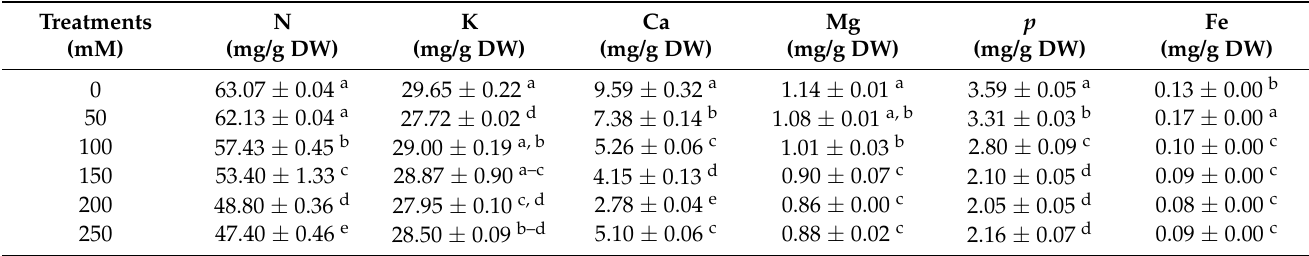
Table 1. Compositions of nitrogen, potassium, calcium, magnesium, phosphorous, and iron in the leaves of H. cannabinus subjected to different levels of salt stress (0, 50, 100, 150, 200, and 250 mM of NaCl). The results are expressed in mg/g dry weight (DW), as means ± SD ( n = 3). According to the Duncan test ( p < 0.05), different letters within a column indicate significant differences.